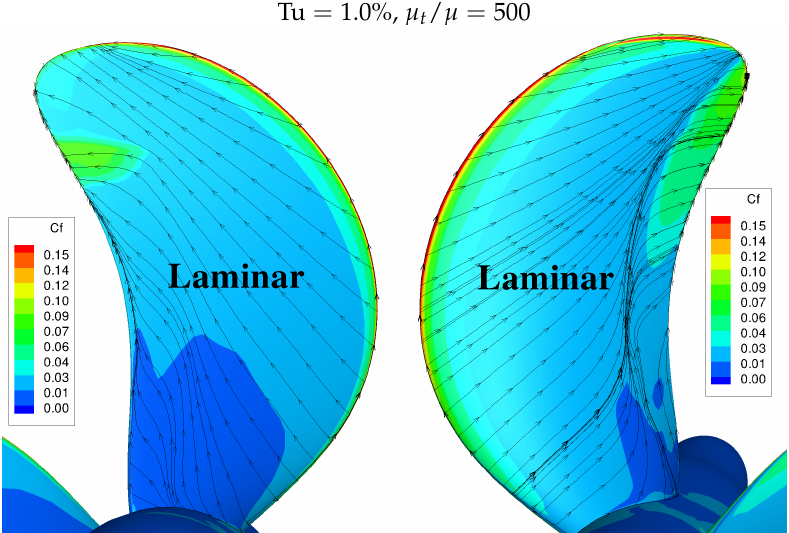
Figure 11. Influence of the inlet turbulence quantities on the propeller blade flow. Limiting stream- lines and skin friction coefficient using the γ − ˜ Re θ transition model at Re = 1 × 10 6 for J = 0.568. t Pressure side ( left ) and suction side ( right ). Table 7. Influence of the inlet turbulence quantities on the propeller forces at Re = 1 × 10 7 for J = 0.568. Turbulence intensity at x / R = 1 refers to section r / R = 0.7. Inlet x / R = 10 x / R = 1 Forces Tu µ t / µ Tu µ t / µ K T 10 K